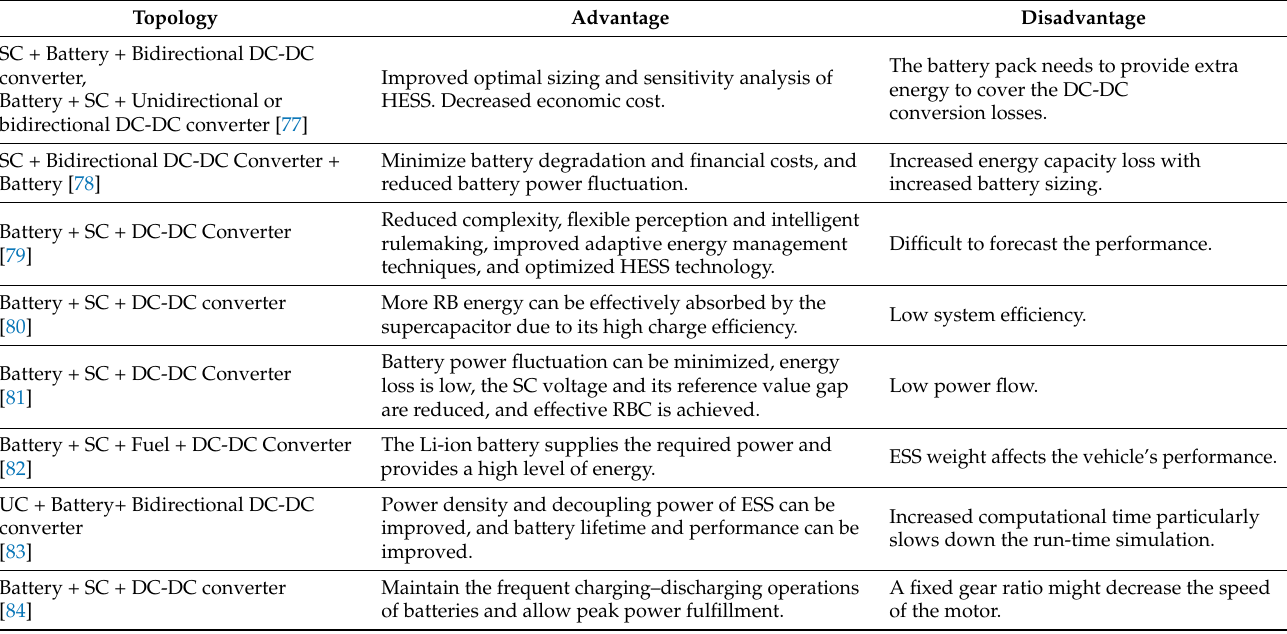
Table 8. Comparison of HESS used for EVs application.